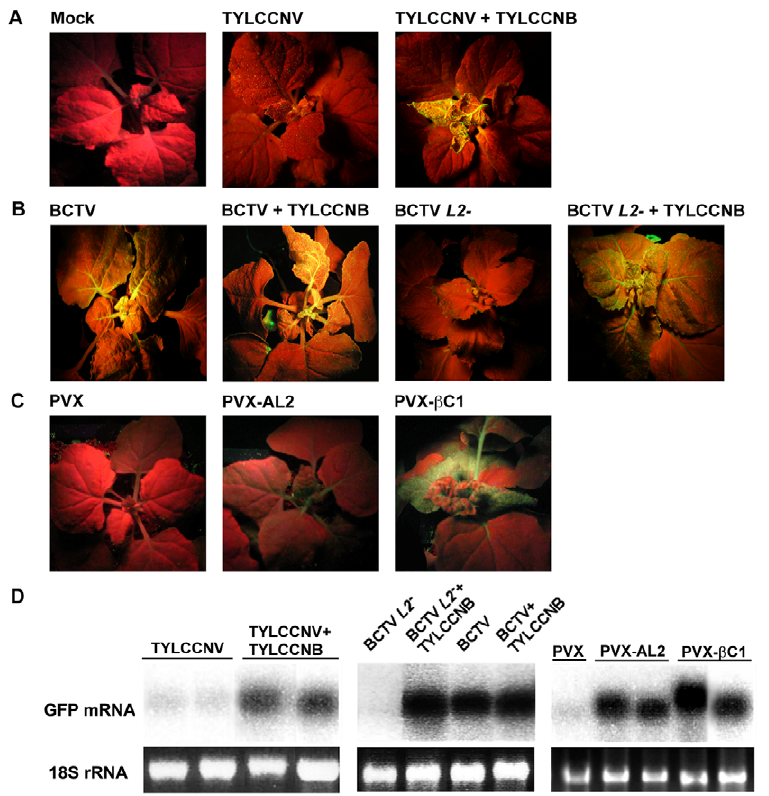
Figure 4. TYLCCNB, or b C1 expression, reverses TGS of a GFP transgene. In experiments with TYLCCNV and PVX, plants were photographed under UV light 14 days post-inoculation. In experiments with BCTV, plants were photographed after 21 days due to the longer latent period of this virus. Results shown are representative of at least three independent experiments with 4 to 8 plants per treatment. (A) N. benthamiana plants containing a transcriptionally silenced GFP transgene (line 16-TGS) were mock inoculated, inoculated with TYLCCNV, or co-inoculated with TYLCCNV and TYLCCNB. (B) Line 16-TGS plants were inoculated with BCTV, BCTV L2-2 (L2 - ) , or co-inoculated with these viruses and TYLCCNB. (C) Plants were inoculated with the PVX vector, PVX expressing AL2 from CaLCuV (PVX-AL2, positive control), or PVX expressing b C1 (PVX- b C1). GFP expression in the PVX-AL2 (CaLCuV) plant shown was less intense than is typically observed [22]. (D) Gel blot analysis of RNA from leaves of 16-TGS plants inoculated as indicated. The 32 P-labeled probe was specific for GFP mRNA. The 18S rRNA loading controls were visualized by ethidium bromide